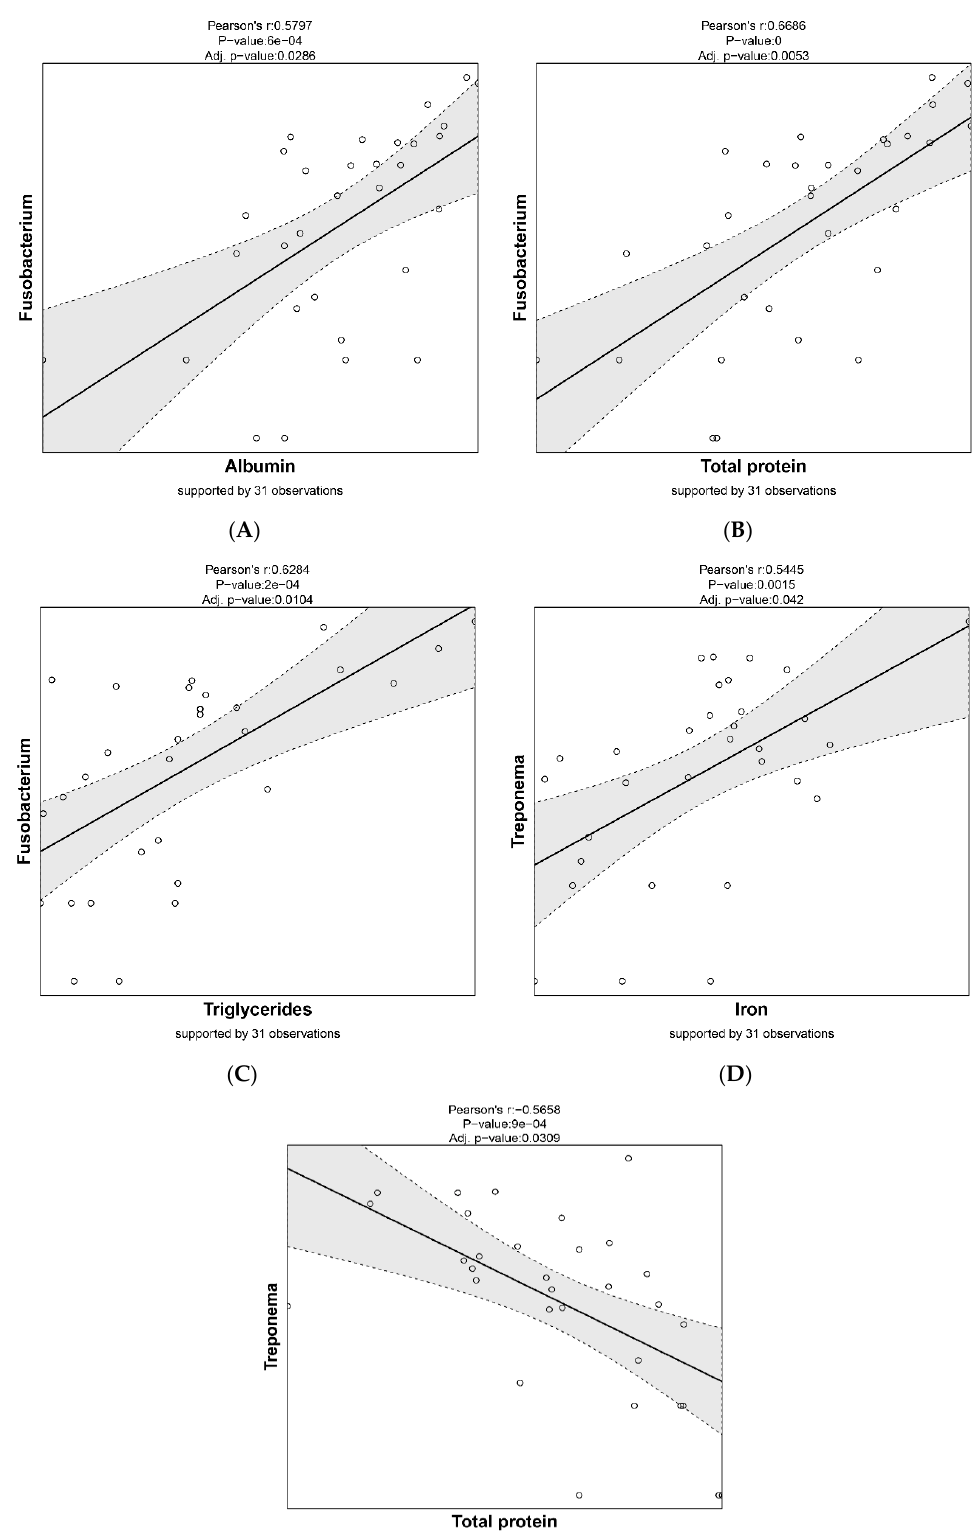
Figure 7. Correlation of significantly different taxa with blood parameters: ( A ) Fusobacterium and albumin, ( B ) Fusobacterium and total protein, ( C ) Fusobacterium and triglycerides, ( D ) Treponema and iron, ( E ) Treponema and total protein (cut-off for scatter plot was p -value < 0.05 and coefficient > 0.5).